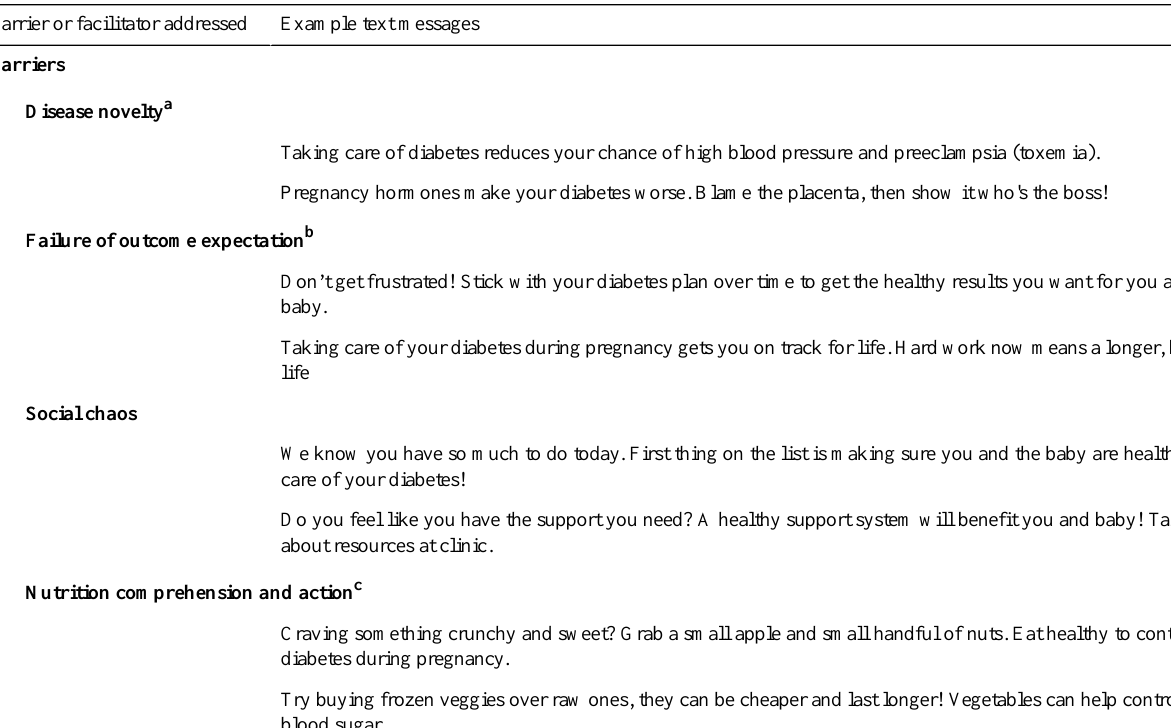
Table 1. Texting for Diabetes Success example messages.